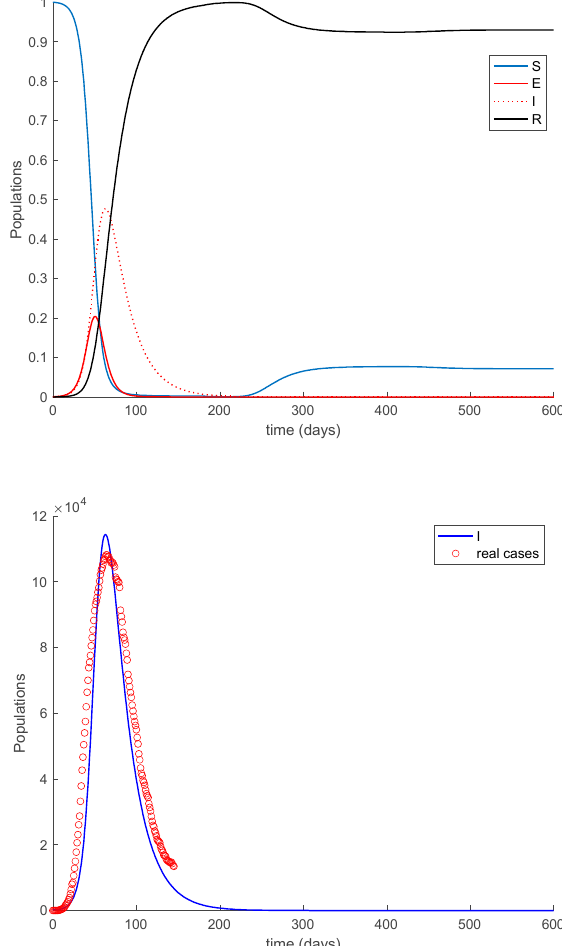
Figure 18. Model dynamics with vaccination and a constant loss of immunity with delay. The vaccination gain is set to K df = 0.1 and it is applied after 180 days.